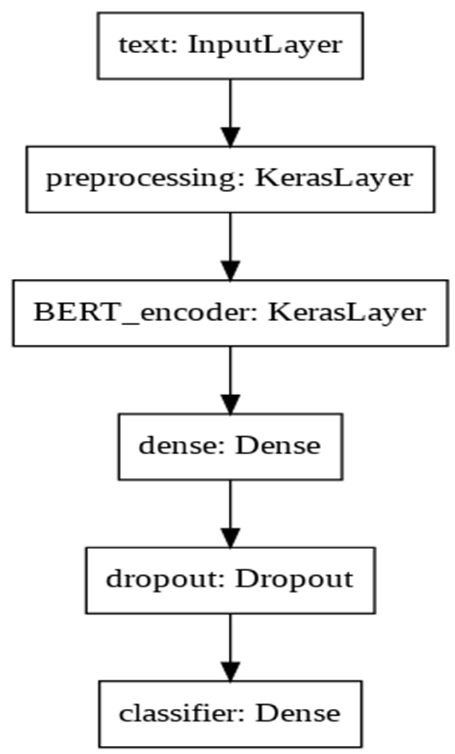
Figure 5. BERT + MLP model architecture.